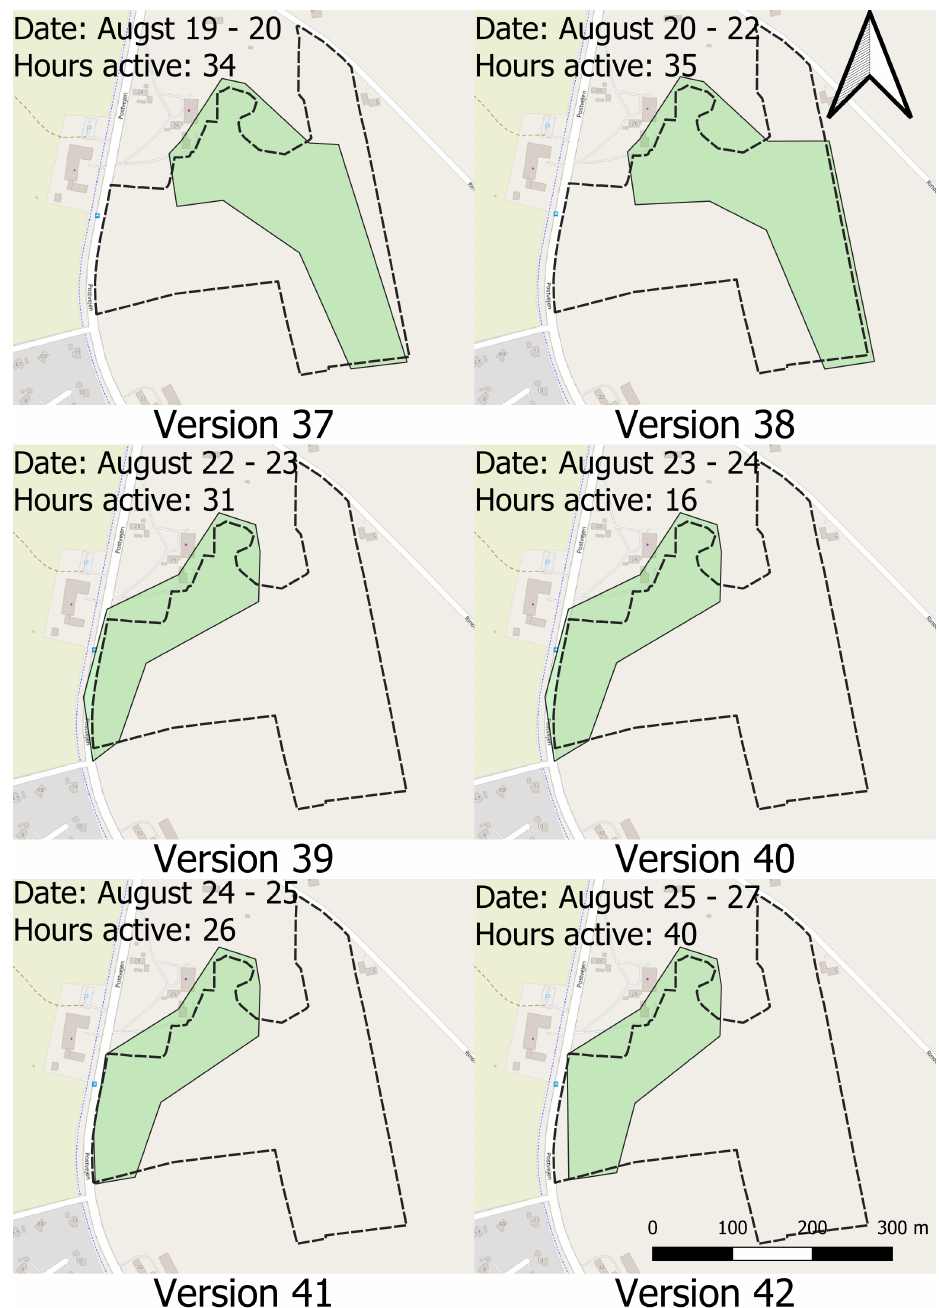
Figure A7. Virtual enclosure version 7 dating from 19 August to 27 August. The dashed black line represents the physical fence surrounding the 8.2 ha grazing area. The marked green area represents the virtual enclosure. Only virtual enclosures active for more than 12 h were included. The coordinates of the upper left corner of the map frame are 55°25 (cid:48) 23.131 (cid:48)(cid:48) E 8°23 (cid:48) 53.531 (cid:48)(cid:48) N. Map data from OpenStreetMaps